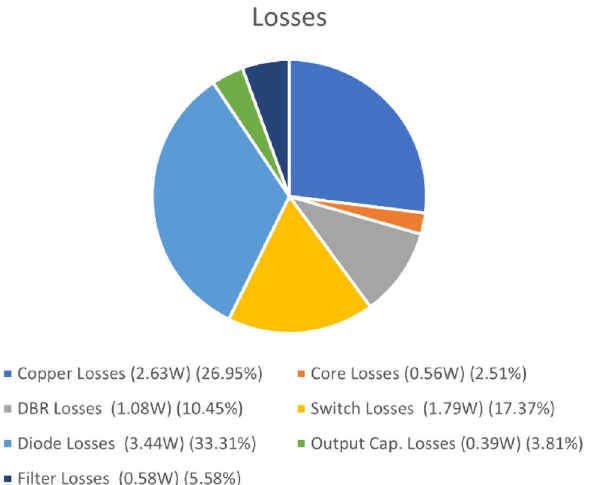
Figure 33. Power Losses of isolated PFC Ćuk